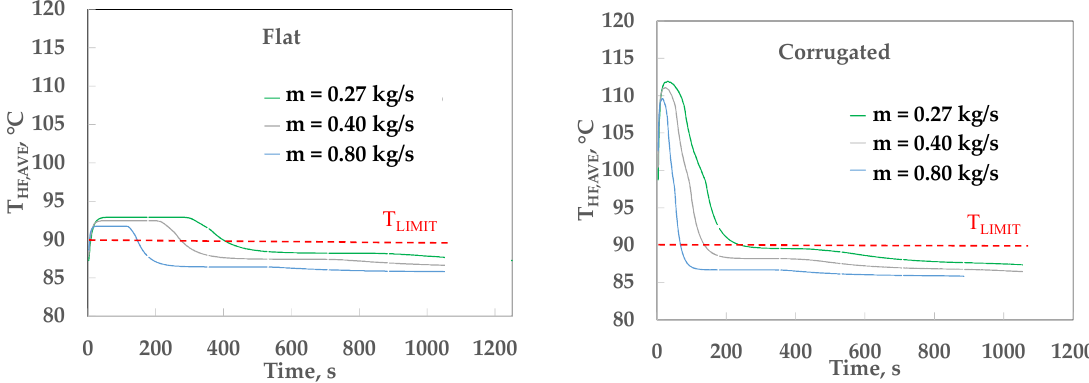
Figure 14. Outlet average temperature of the HF at different flowrates.